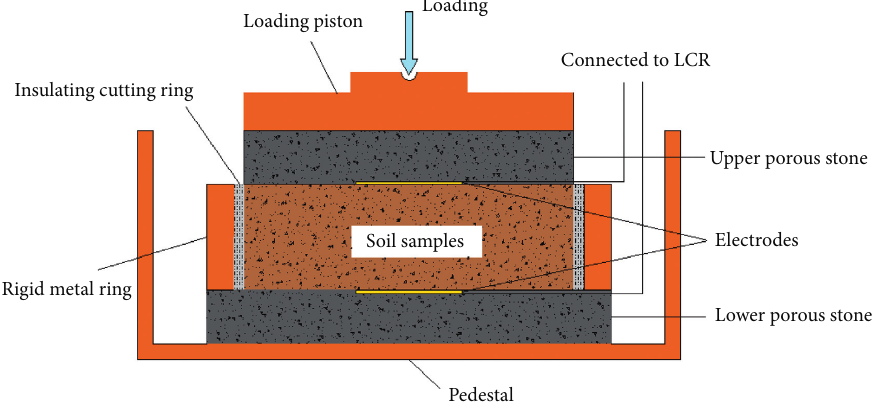
Figure 3: Schematic diagram of the developed consolidation